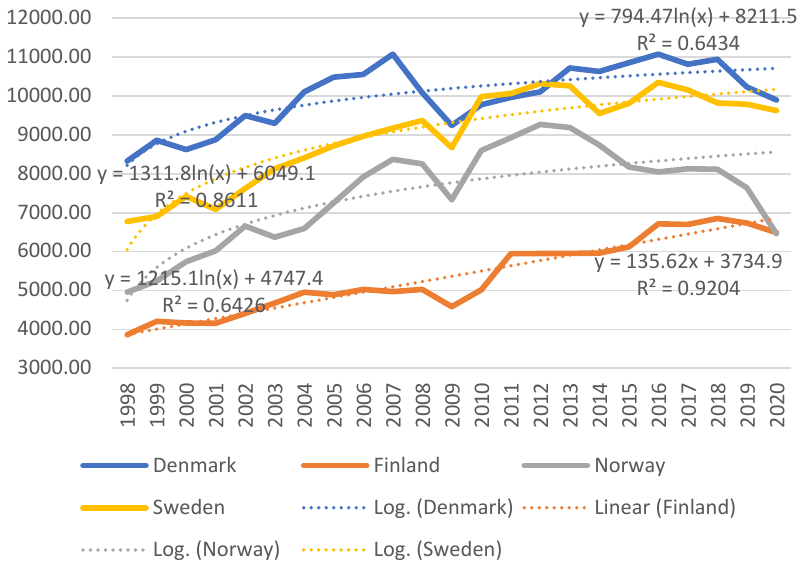
Figure 4. Green taxes in Nordic countries (million Euros). Source: Nordic Statistics database [31]. The change in total green taxes in Norway, Denmark, and Sweden could be described by logarithmic function rather than linear function, which means that the margin for a tax rate in that country is minimal or does not exist. According to the Laffer curve, increasing taxation would result in lower tax revenue. In Finland, the change in total green taxes could be described by linear function rather than logarithmic function. That means that the margin for a tax rate in that country still exists, and taxation could be increased along with tax